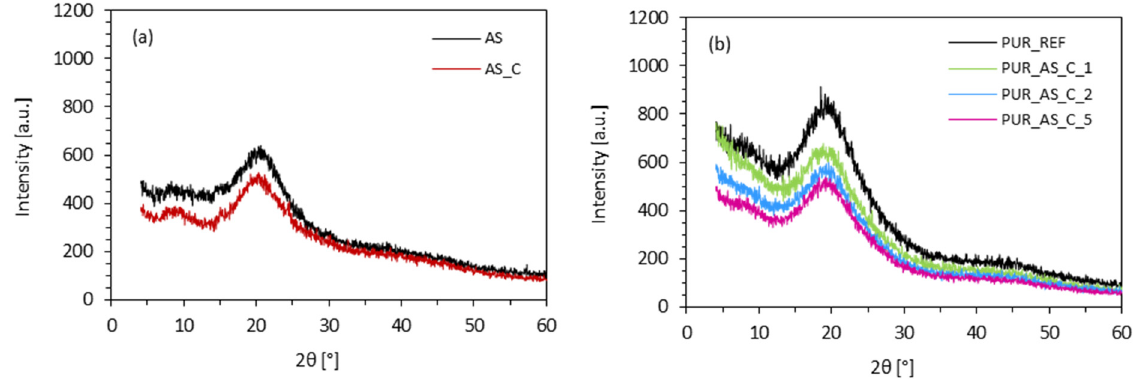
Figure 11. XRD patterns of ( a ) apricot-stone fillers and ( b ) PUR composites reinforced with casein/apricot filler.